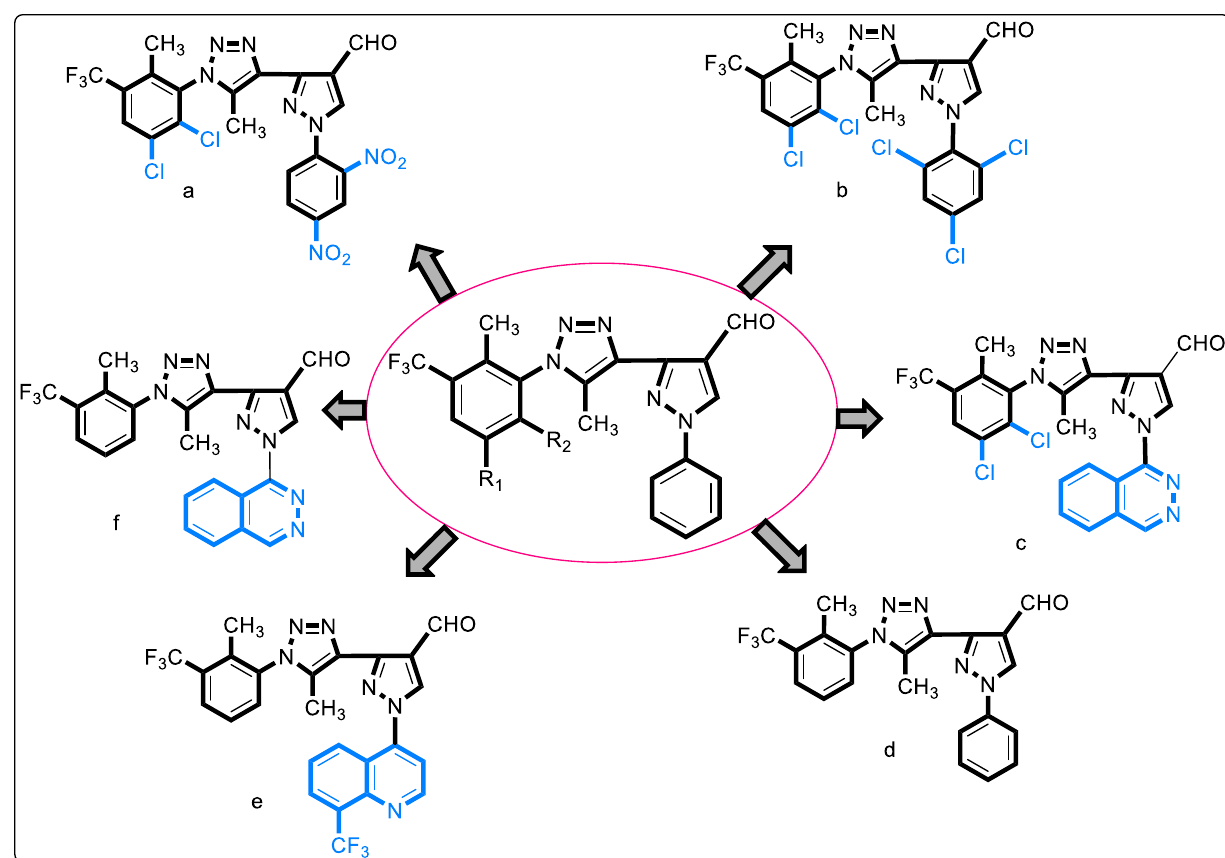
Figure 3. Modifications of the core scaffold of triazolyl pyrazole MurB inhibitors. ( a ) 3-(1-(2,3-di-